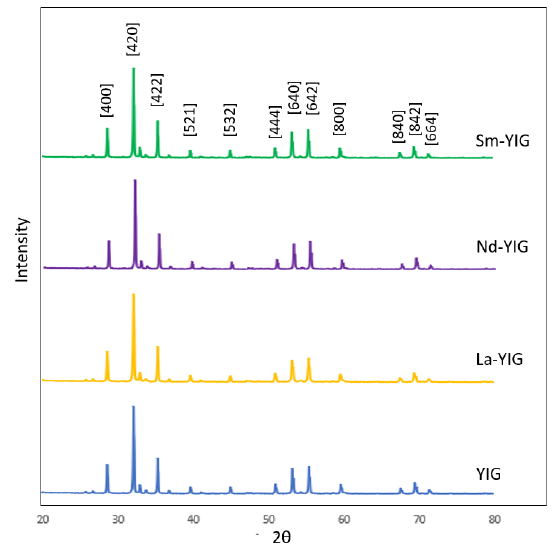
Figure 2. X-ray Powder Diffraction (XRD) pattern of RE-YIG nanoparticles.